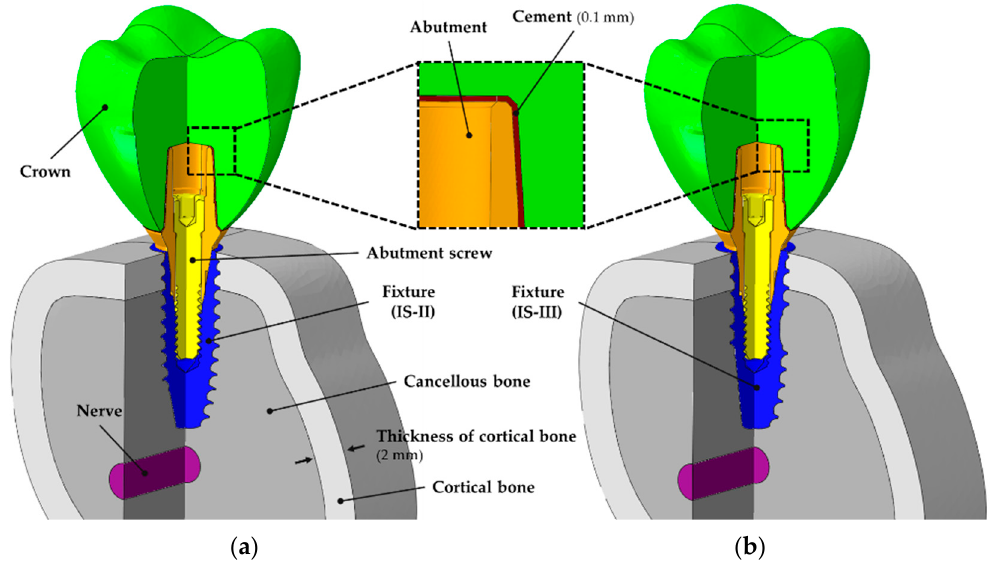
Figure 3. Cross-sectional view of three-dimensional finite element models for a single-tooth surgery showing the internal assembly structure and cement layer. ( a ) CMI IS-II active fixture and ( b ) CMI IS-III active fixture.